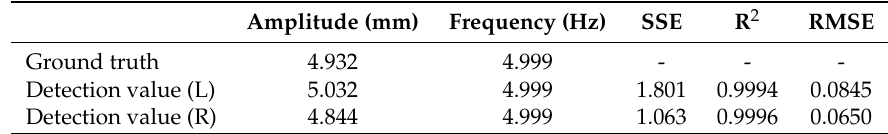
Table 2. Fitting evaluation parameters of the reconstruction results.